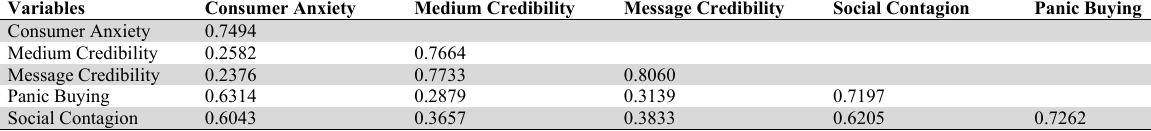
Results of Discriminant Validity Test with Fornell-Larckner Criterion Variables